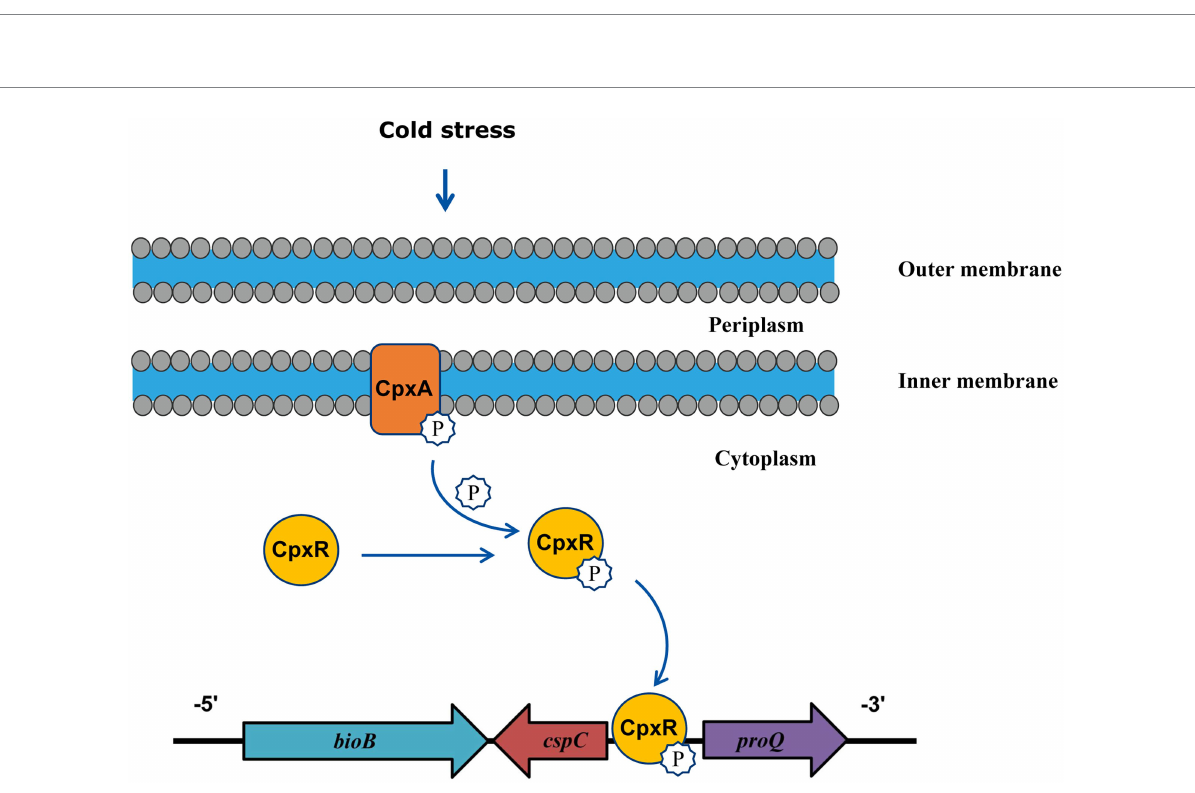
FIGURE 5 Model illustrating that CpxA/CpxR mediates cold stress in A. pleuropneumoniae . Under cold stress, phosphorylated form of CpxA transfers the phosphate group to CpxR, then the active CpxR binds the promoter of the cspC gene to upregulate its